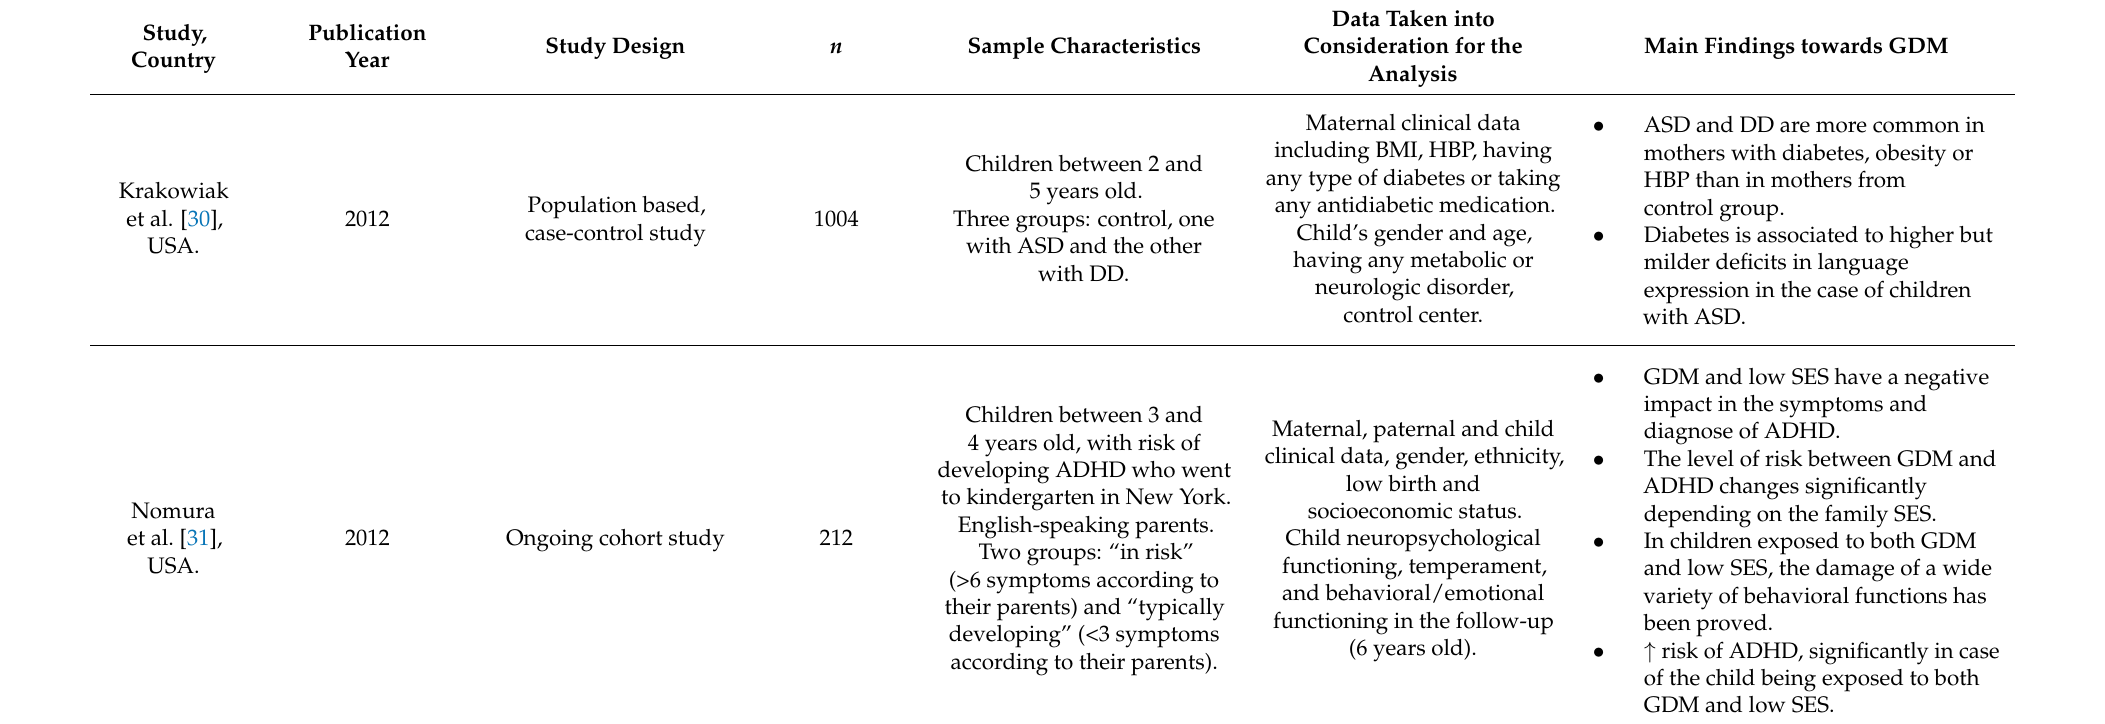
Table 2. Characteristics of studies in relation with GDM, fetus and neurodevelopmental